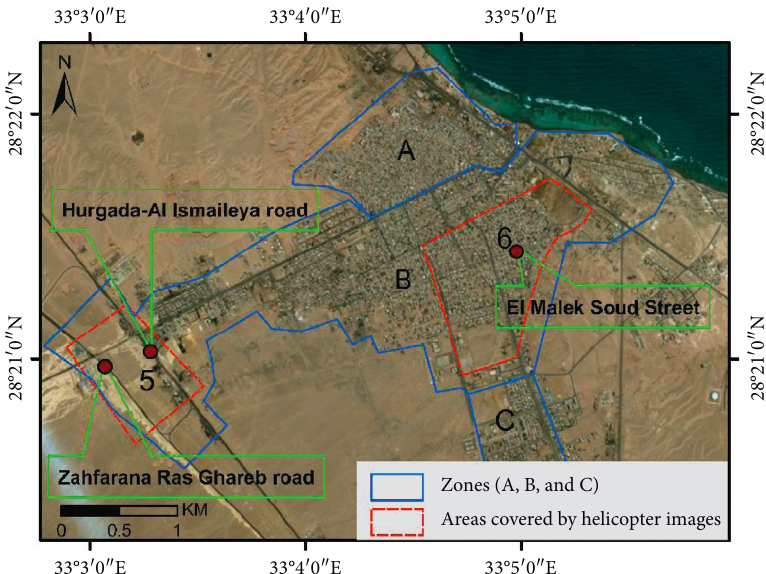
Figure 4: The streets through the study area in addition to the areas covered by the helicopter images after the flash